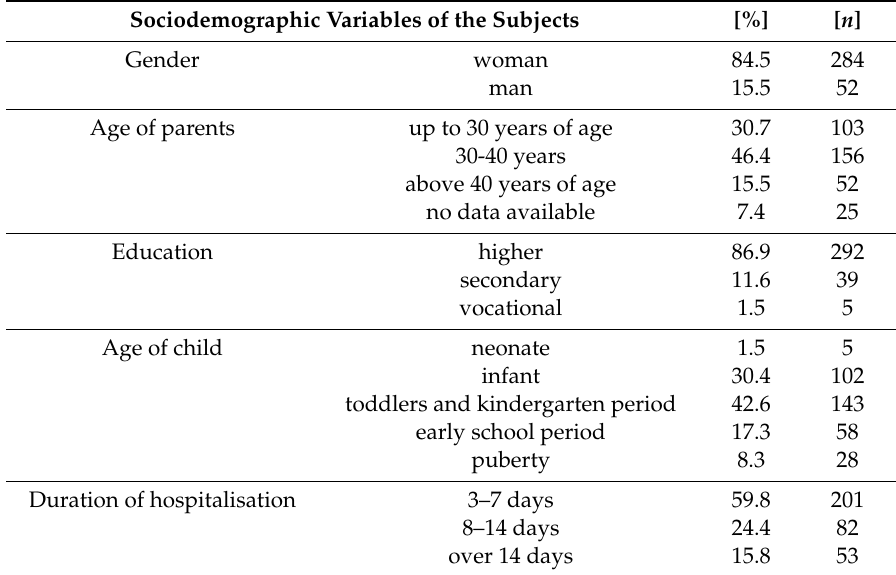
Table 1. Characteristics of the study